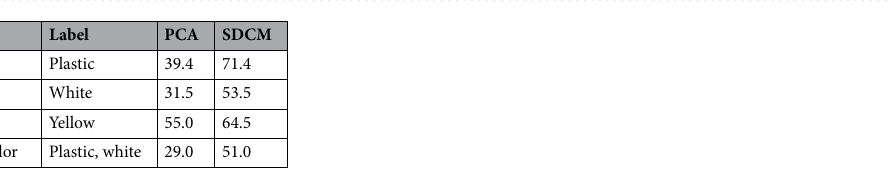
Table 2. f 1 scores of the four ECs which only contain a single, unambiguous